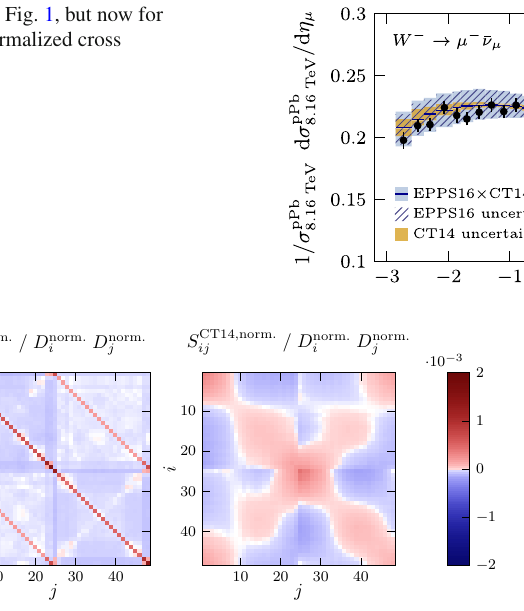
Fig. 4 AsFig.2,butnowfortheself-normalizedcrosssections.Indices i , j followthesameorderingasthedatapointsinFig.3,withtheindices 1 through 24 corresponding to the W − production and 25 through 48 to W